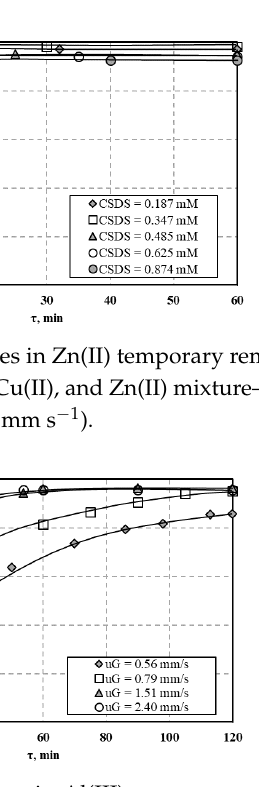
Figure A17. Changes in Cu(II) temporary removal ratio during precipitate flotation from solution containing Al(III), Cu(II), and Zn(II) mixture—effect of collector concentration (c 0 = 2 mmol dm − 3 , pH = 8.7, u G = 1.51 mm s − 1 ).